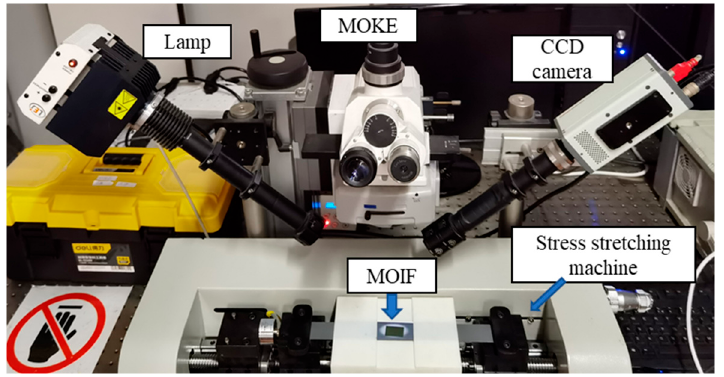
Figure 2. Magnetic domain acquisition and mechanical system.